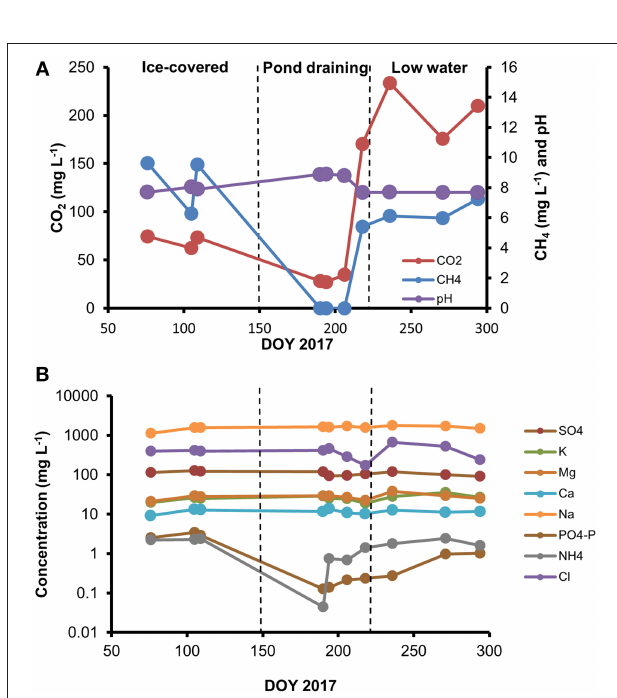
FIGURE 4 | Time series observations of the principal water quality results given in Table 1 . (A) pH and the dissolved gases, (B) major